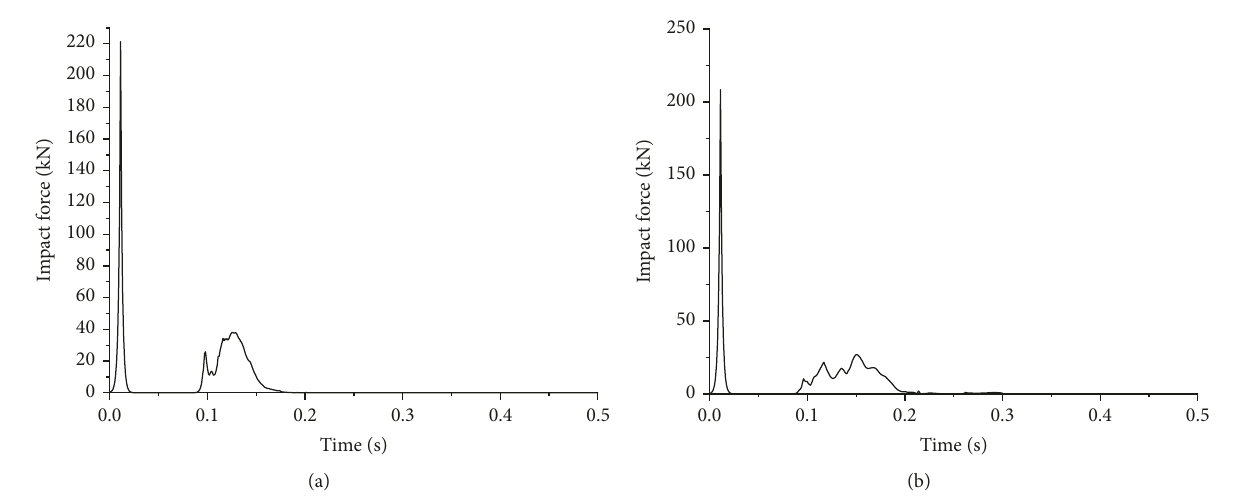
Figure 22: Impact time history curves: (a) model 10 and (b) model 11.